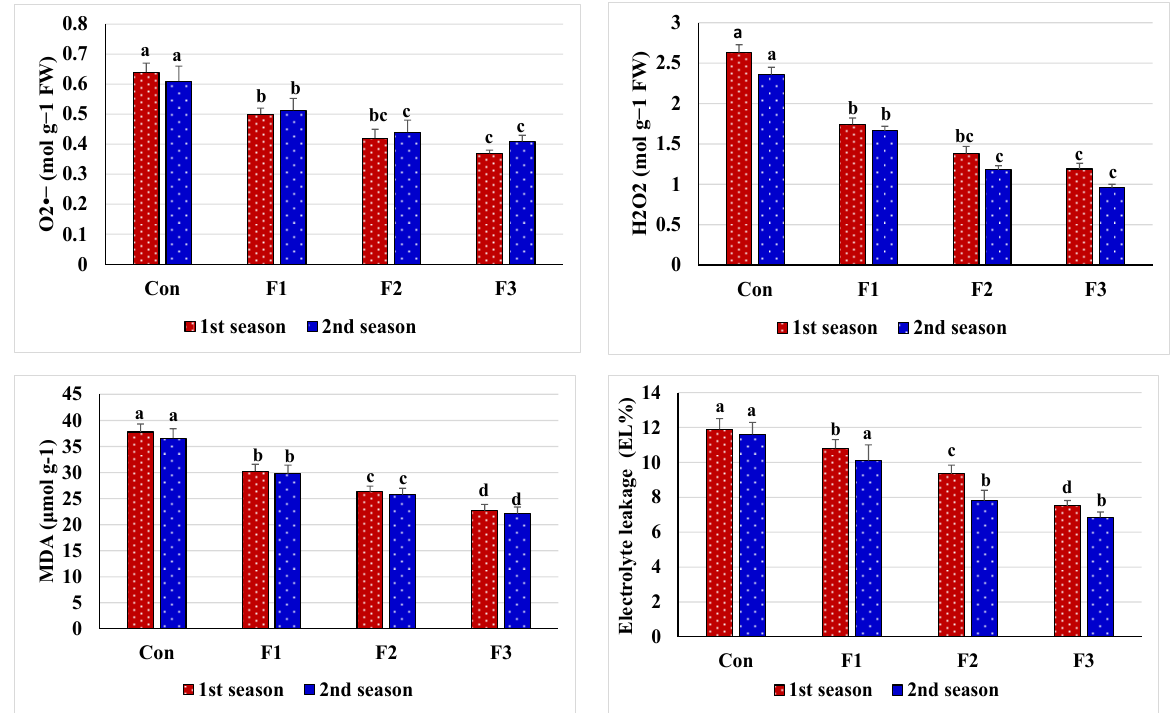
Figure 1. Oxidative stress markers and their outcomes responses of salt-stressed common bean plants (soil EC = 7.55 − 7.61 dS m − 1 ) to foliar nourishment with selenium dioxide nanoparticles (Se-NPs) in two consecutive seasons. Above bars, different letters are considered significantly different at p ≤ 0.05. Con, control (spraying leaves with distilled water); F1, spraying leaves with 0.5 mM Se-NPs; F2, spraying leaves with 1 mM Se-NPs; F3, spraying leaves with 1.5 mM Se-NPs; MDA, lipid peroxidation measured as malondialdehyde; H 2 O 2 , hydrogen peroxide; O 2 •− , superoxide radical.